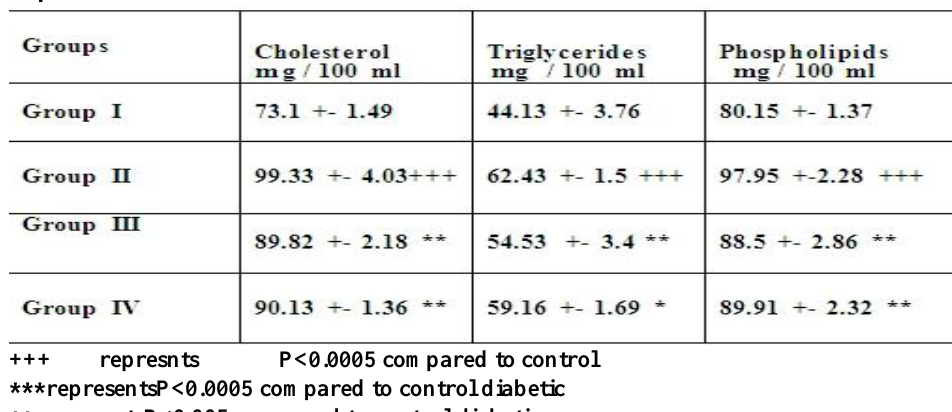
T able-3: Change in serum cholesterol, triglyceride, phospholipids in control and experimental